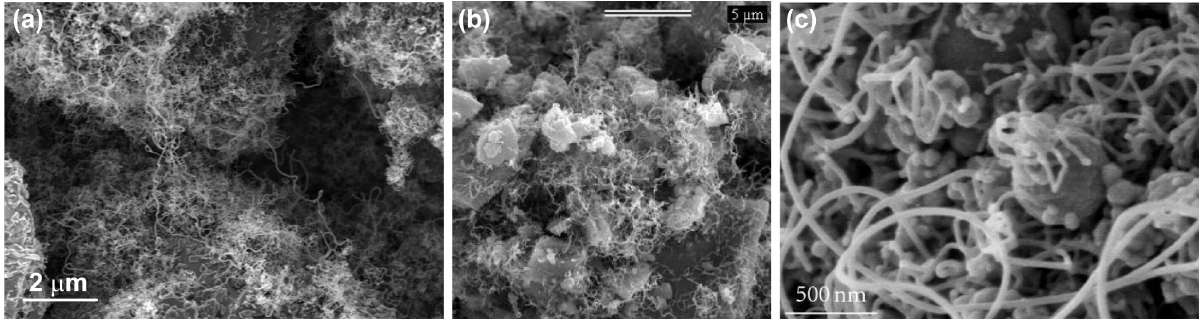
Figure 17: (a) CNFs grown on clinker [163]; CNTs grown on (b) cement clinker [164]; (c) silica [165]; the nano-hybrids in this figure were fabricated with the conventional CVD method